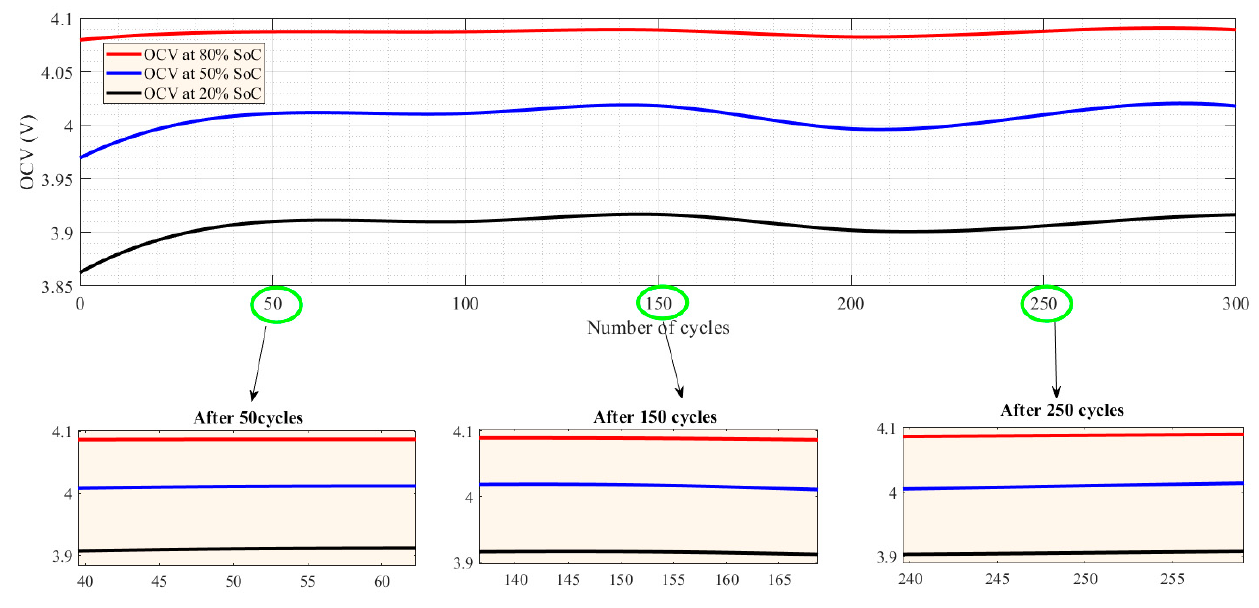
Figure 6. OCV pattern at 45 °C under charge–discharge STPs after 300 cycles during the lifetime of the 3Ah NMC Li-ion battery.